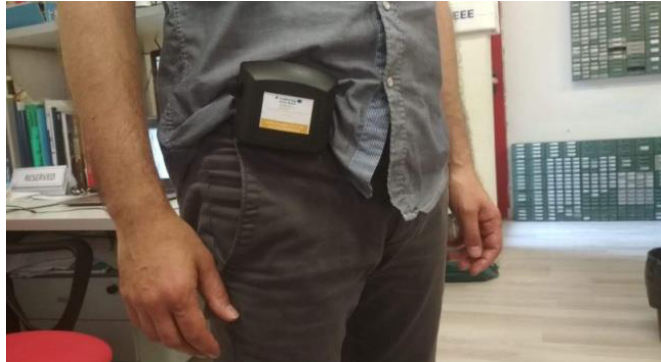
Figure 2. Device overview: ( a ) real view of the device; ( b ) the Android interface.